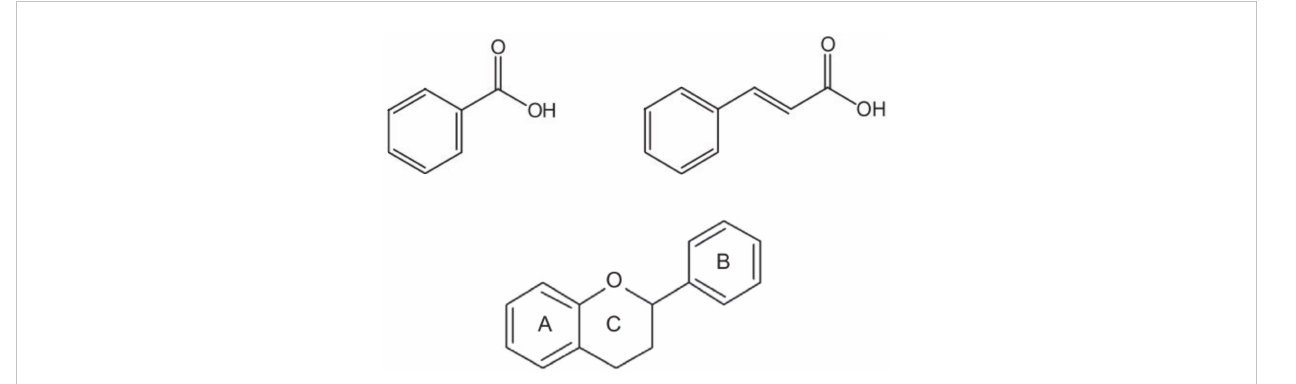
FIGURE 1 Basic structure of benzoic acids (top left), which has a carboxylic group attached to the aromatic ring (C6-C1 backbone), cinnamic acids (top right), which has a propanoic acid attached to the aromatic ring (C6-C3 backbone), and fl avonoids (bottom), consisting of a benzo- g -pyrone ring (A) and a phenyl ring (B) bound by an oxygen-containing g -pyrone ring (C)